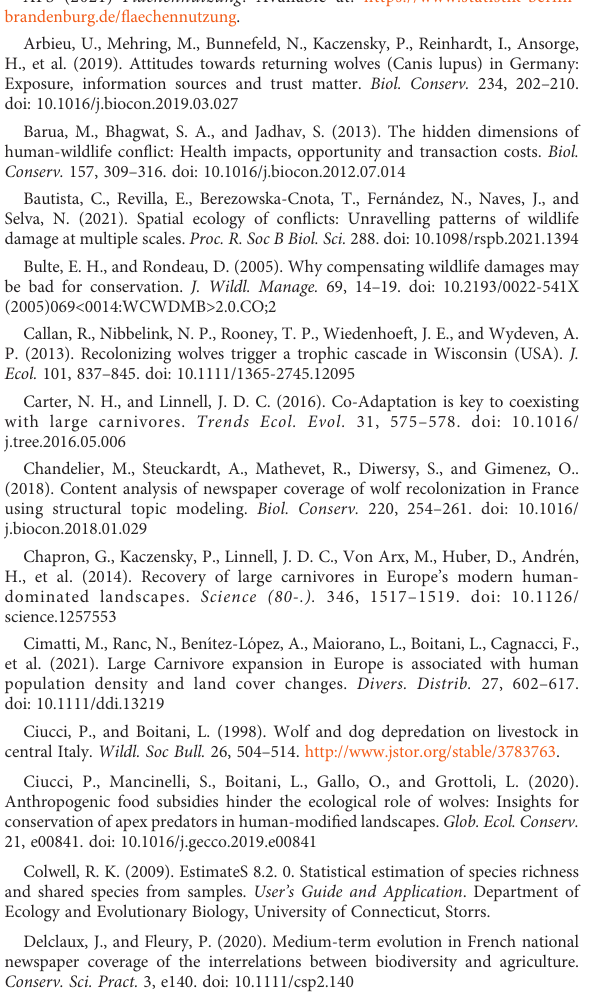
SUPPLEMENTARY FIGURE 1 Predicted effects of livestock species category and farm type on the number of killed livestock individuals per reported wolf predation event. Predictions are based on the negative binomial regression model summarized in Table 1.